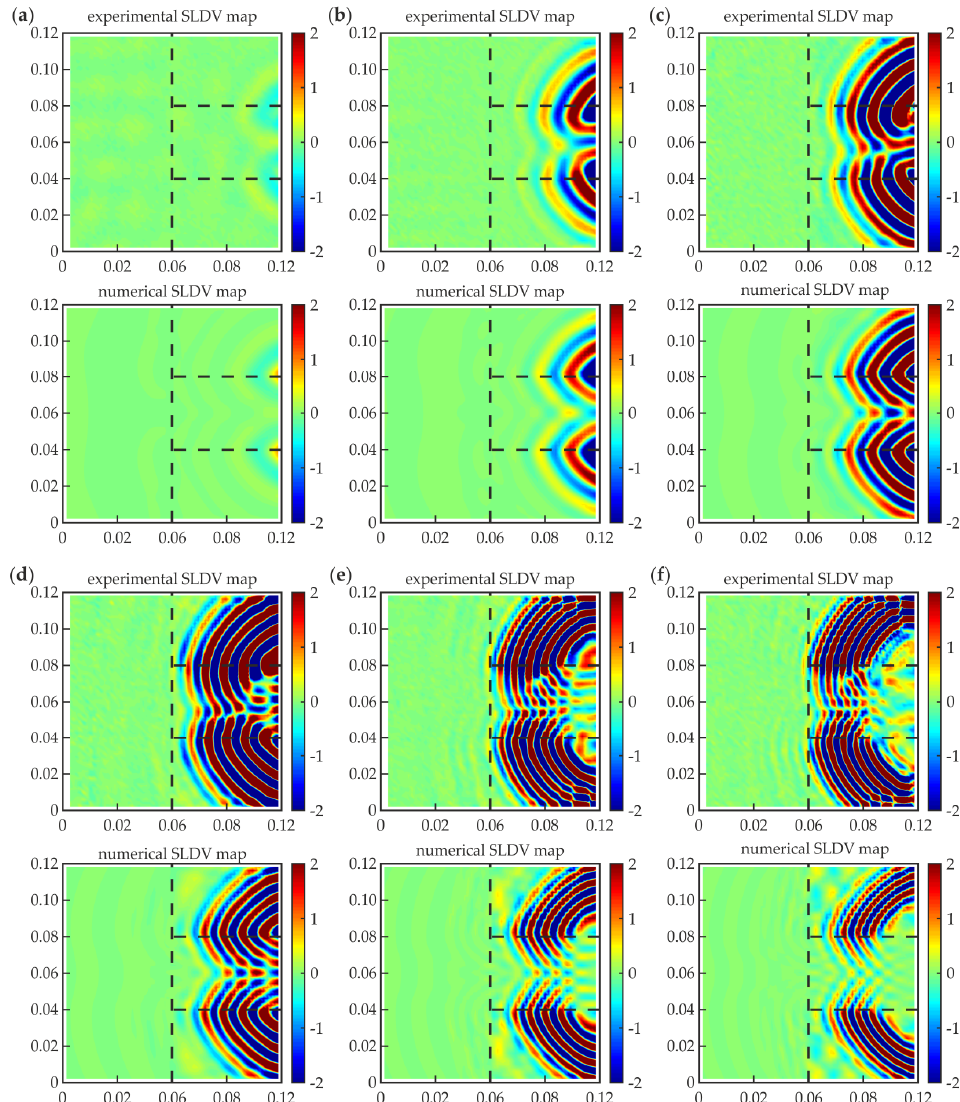
Figure 8. Experimental and numerical guided wave fields (values in m/s·10 −3 ) for a specific time, 30 μs, and different excitation frequencies: ( a ) f = 50 kHz; ( b ) f = 100 kHz; ( c ) f = 150 kHz; ( d ) f = 210 kHz; ( e ) f = 300 kHz; and ( f ) f = 350 kHz.